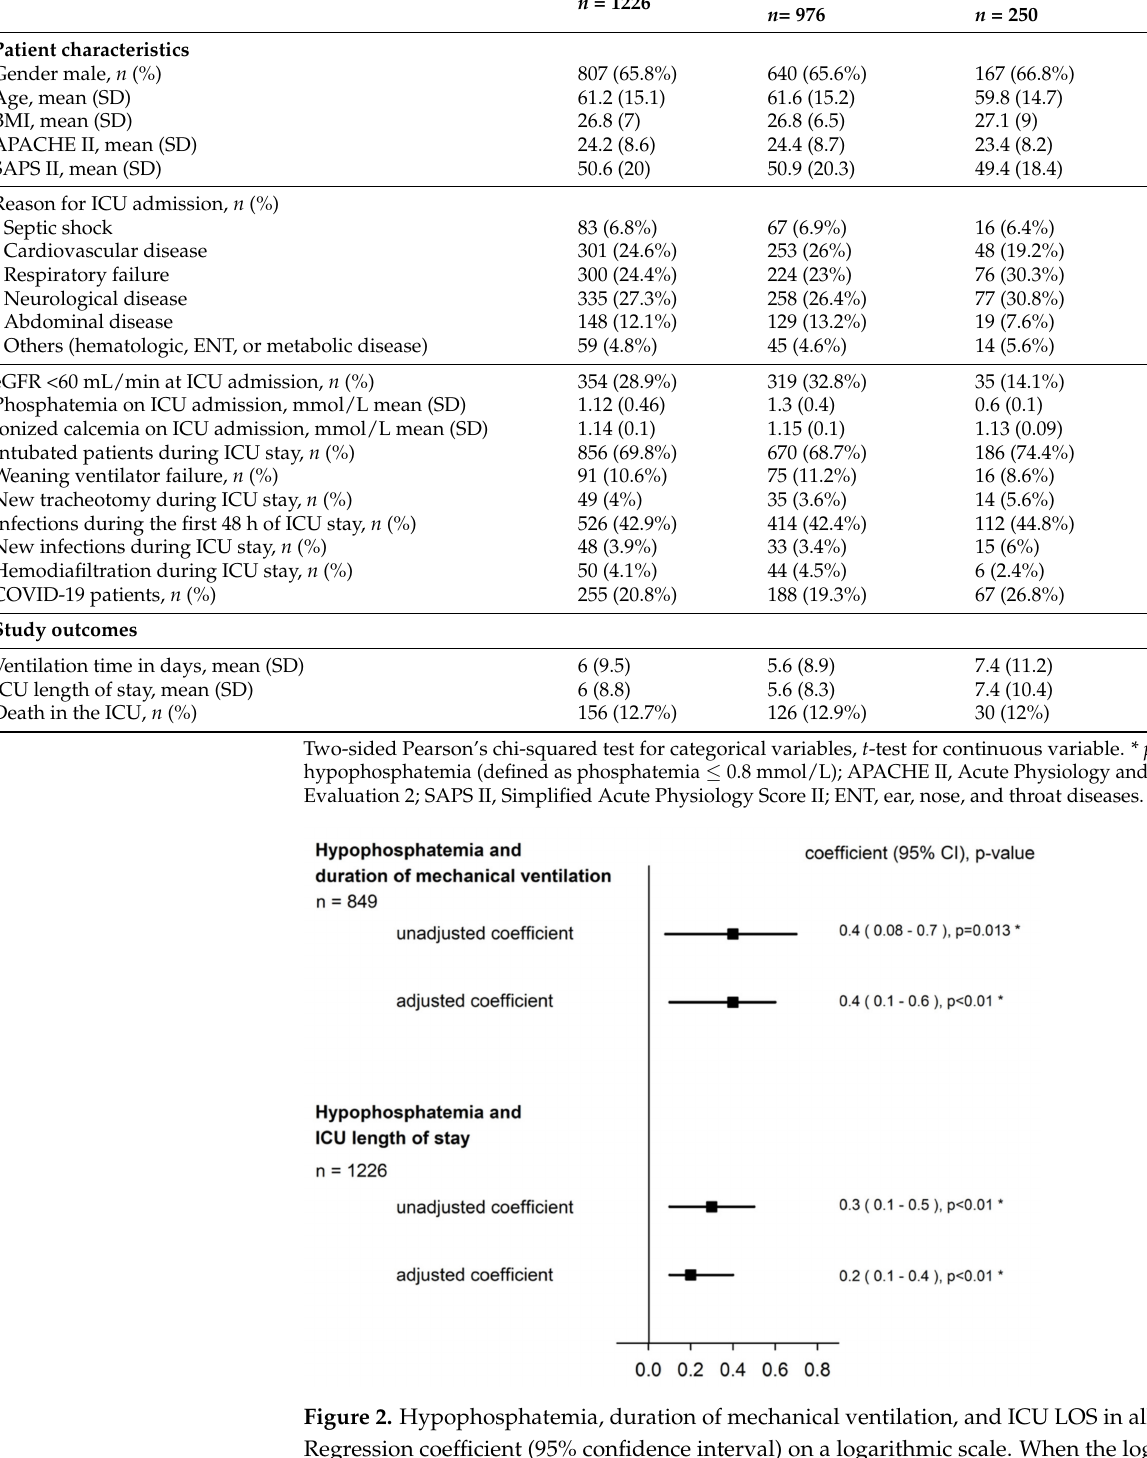
Table 1. Characteristics and differences between hypophosphatemic and non-hypophosphatemic critically ill patients. Total n = 1226